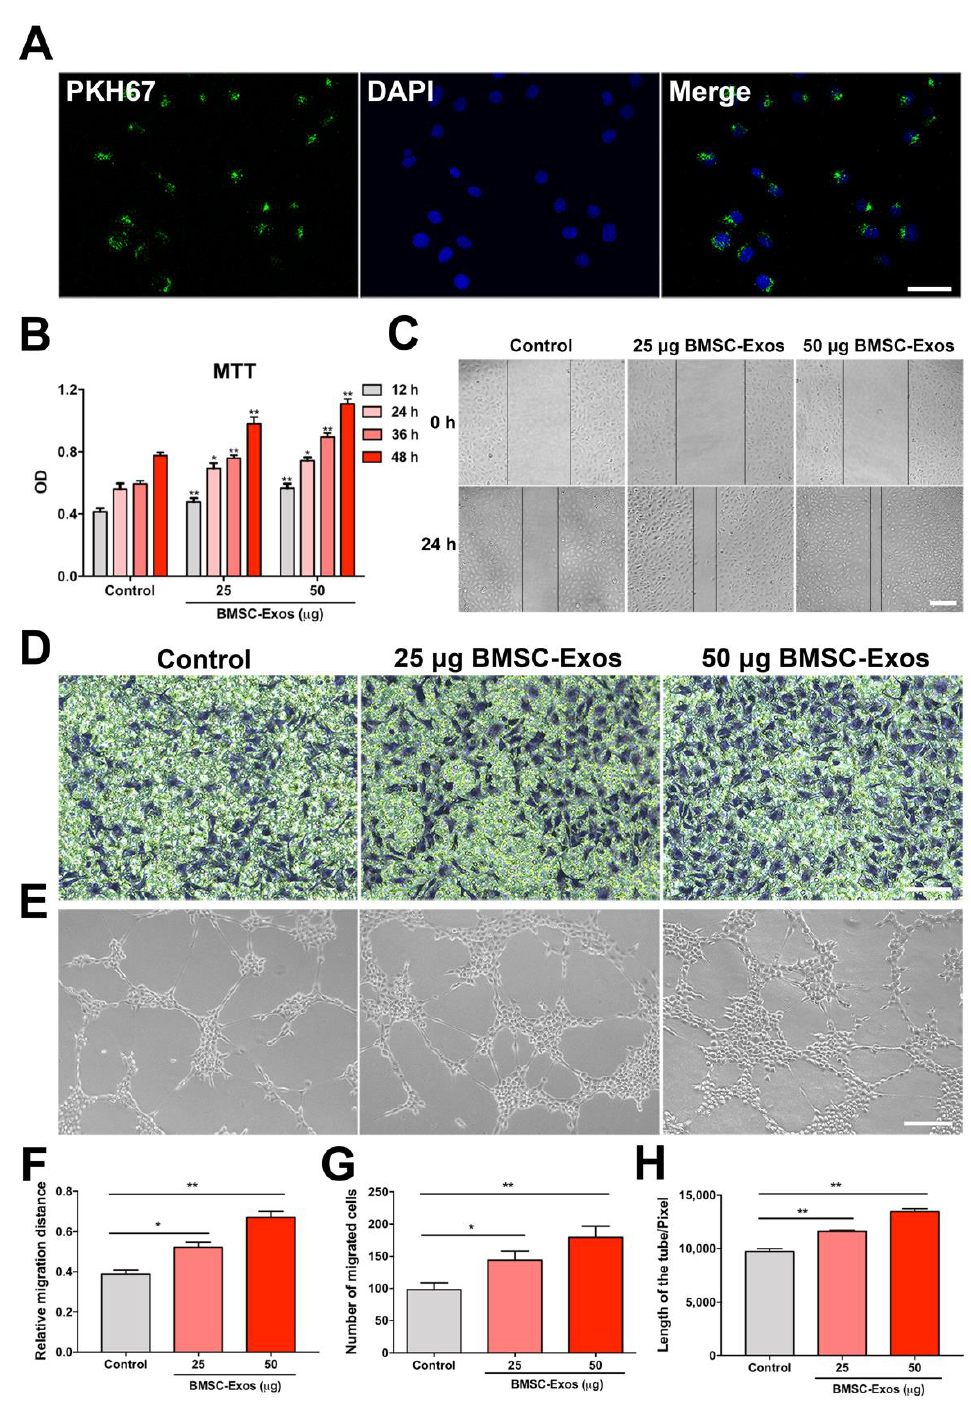
Figure 7. BMSC-Exos promoted proliferation, migration and tube formation of HUVECs. ( A ) PKH- labeled BMSC-Exos were uptake by HUVECs. Scale bar = 5 0 μm. ( B ) Cell viability was determined by MTT assay. n = 6/group. * p < 0.05. ** p < 0.01. ( C ) Representative images of scratch assay in HUVECs. Scale bar = 2 00 μm. ( D ) Representative images of migrated HUVECs in Transwell assay. Scale bar = 1 00 μm. ( E ) Representative images of tube formation of HUVECs. Scale bar = 2 00 μm. ( F ) Relative measurement of migration distance. n = 3/group. * p < 0.05. ** p < 0.01. ( G ) Number of mi- gration cells in Transwell assay. n = 3/group. * p < 0.05. ** p < 0.01. ( H ) Total length of tube formed by HUVECs. n = 3/group. ** p < 0.01. DAPI, 4 ′ ,6-diamidino-2-phenylindole; MTT, 3-(4,5-dimethyl-2- thiazolyl)-2,5-diphenyl-2-H-tetrazolium bromide; OD, optical density; BMSC-Exos, bone marrow mesenchymal stem cell-derived exosomes.